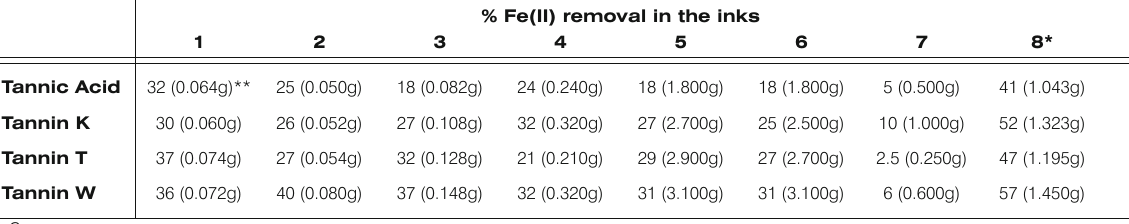
Table 2. Percent Fe(II) removal after treatment with calcium phytate solution (naturally aged paper strips containing iron-gall